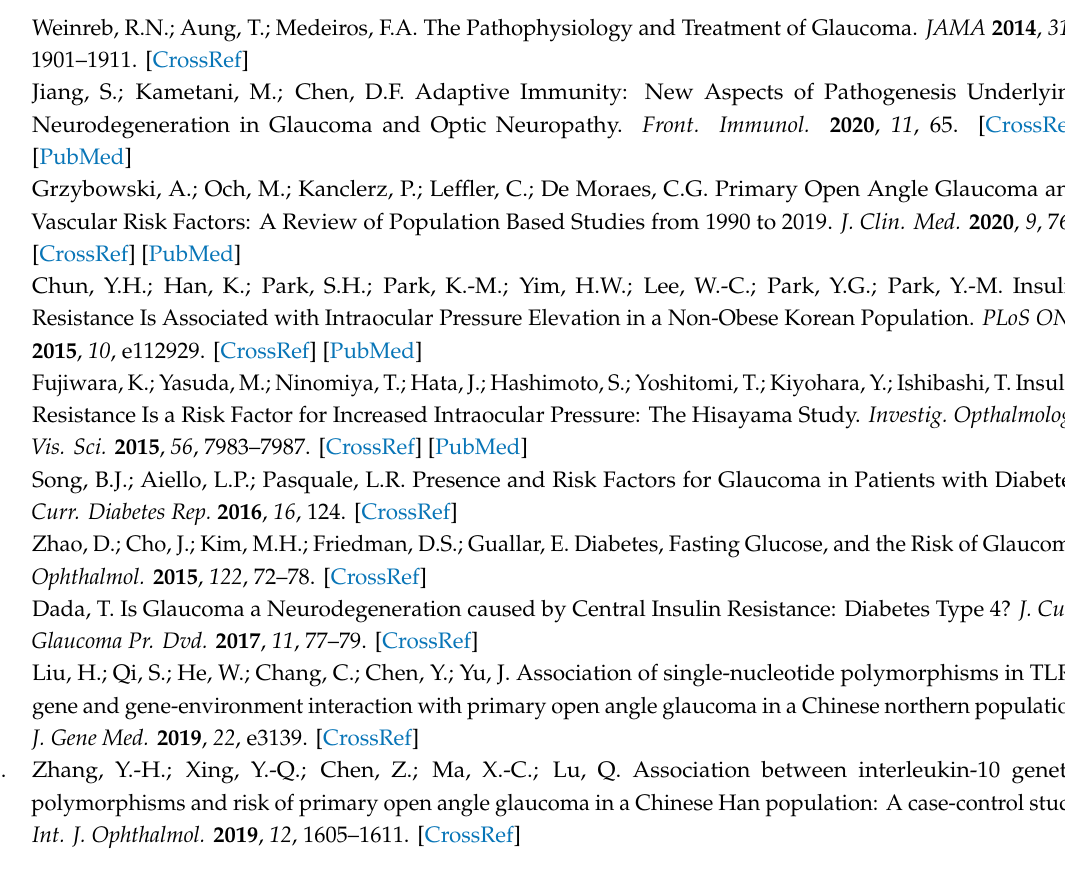
Table S1: Generalized multifactor dimensionality reduction (GMDR) results of multi-locus interaction with genes related to